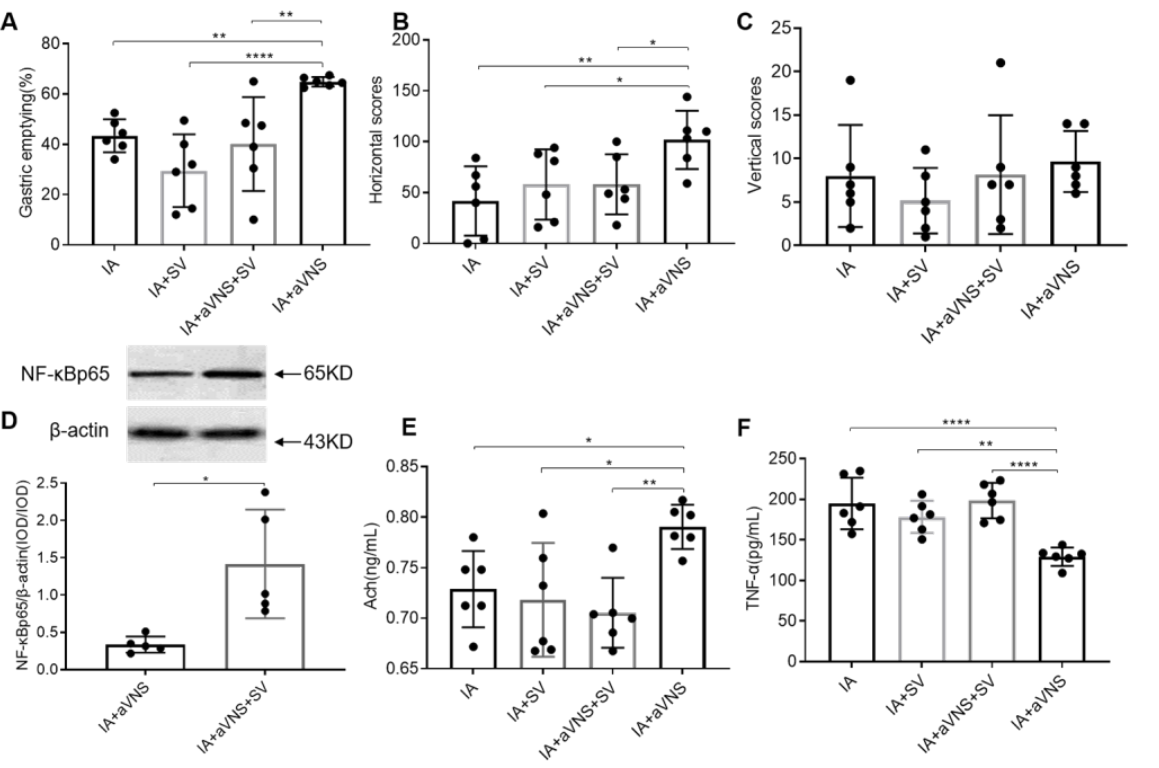
Figure 7. The effect and mechanism of vagotomy in IA-treated rats. ( A – C ) The gastric emptying and OFT results in all rats. ( D ) Expression of duodenal NF- κ Bp65 after two weeks of intervention. ( E ) The release of gastric Ach in all rats. ( F ) The serum level of inflammatory cytokines TNF- α in all rats. One-way ANOVA was used, and the LSD method was used for post hoc tests in ( A – C , E , F ). The independent sample t-test was used in ( D ). IA: IA-treated rats. IA + SV group: IA-treated rats received SV with no intervention. IA + aVNS group: IA-treated rats with 2 weeks of aVNS; IA + aVNS + SV group: IA-treated rats received SV with 2 weeks of aVNS. SV: subphrenic vagotomy. * p < 0.05, ** p < 0.01, **** p < 0.0001. n = 6 per group. Data were presented as means ± standard deviation.